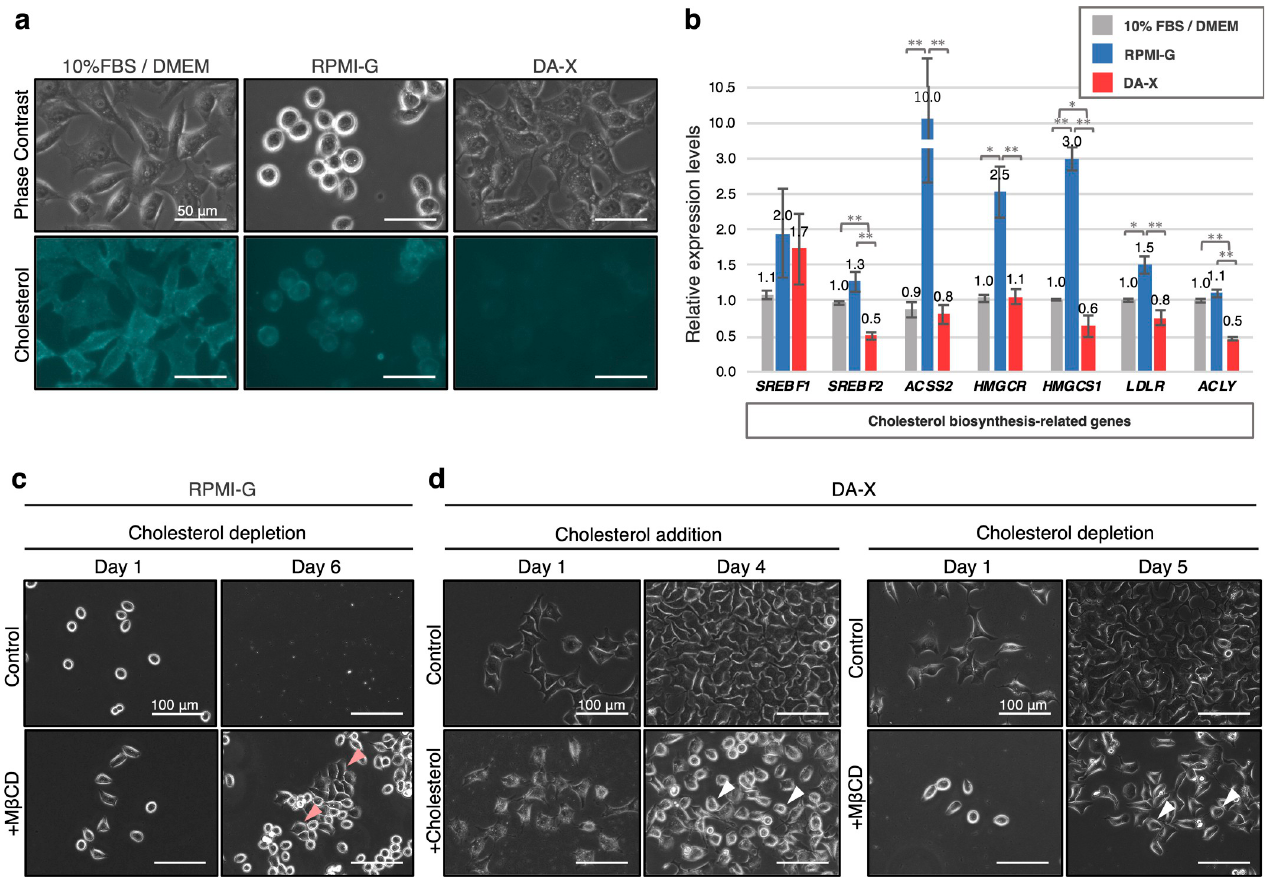
Fig 3. Required cholesterol level on membrane optimized by DA-X condition in HeLa cells. a, Cholesterol labeling with filipin fluorescence staining in each culture condition. Cells were cultured in 10% FBS/ DMEM, RPMI-G, DA-X condition for 2 days, and then applied for the staining. Signals of fluorescence were enriched in membrane of cells regardless of culture condition, and the intensity was strong in 10% FBS/ DMEM and RPMI-G, but quite faint in DA-X condition. Images for filipin staining were obtained using the same exposure time. Scale bar, 50 μ m. b, Quantitative PCR analysis of expression of de novo cholesterol biosynthesis-related genes. Cells cultured in each condition for 2 days, and collected for further gene expression analysis. Error bars indicate s.d. (n = 3, biological replicates). t-test, �� p < 0.01 and � p < 0.05. c, Enhancement of cell adhesion and proliferation by depletion of membrane cholesterol with Methyl- β -cyclodextrin (M β CD) at 0.2 mM in RPMI-G culture medium. Pink arrowheads indicate cells with firm elongated pseudopodia. d, Effects of excess and depletion of membrane cholesterol on cell adhesion by addition of soluble cholesterol and M β CD in DA-X condition. At day 4 and 5, attenuated cell adhesion with the retraction of pseudopodia was widely observed not only in addition of cholesterol, but also in depletion of membrane cholesterol with M β CD at 1 mM. Scale bar, 100 μ m. White arrowheads indicate cells with losing attachment.